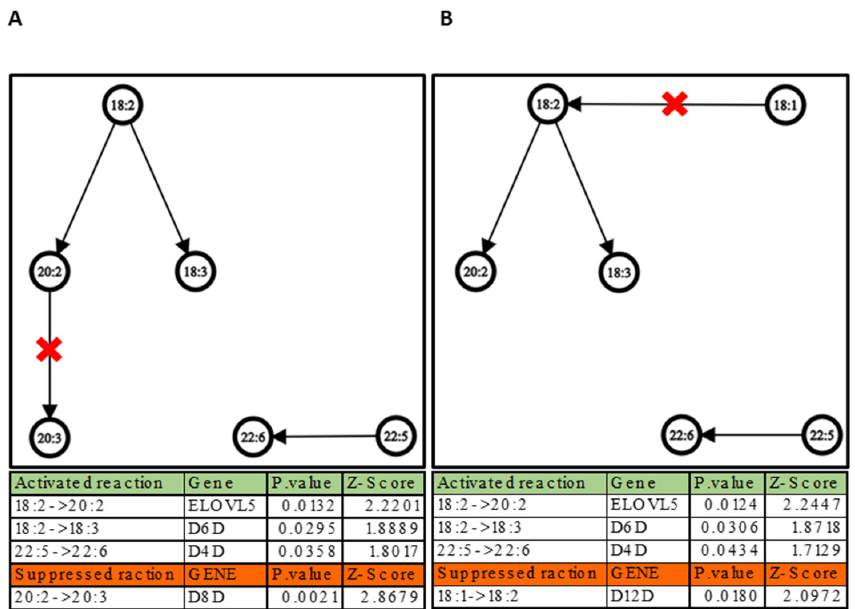
Figure 3. Heatmap : The figure shows the correlation of the 35 most significant lipid molecular species within each sample. The color shows the level of expression of each individual species in each sample based on their concentrations. The analysis was performed using the Pearson correlation index and the complete clustering method.